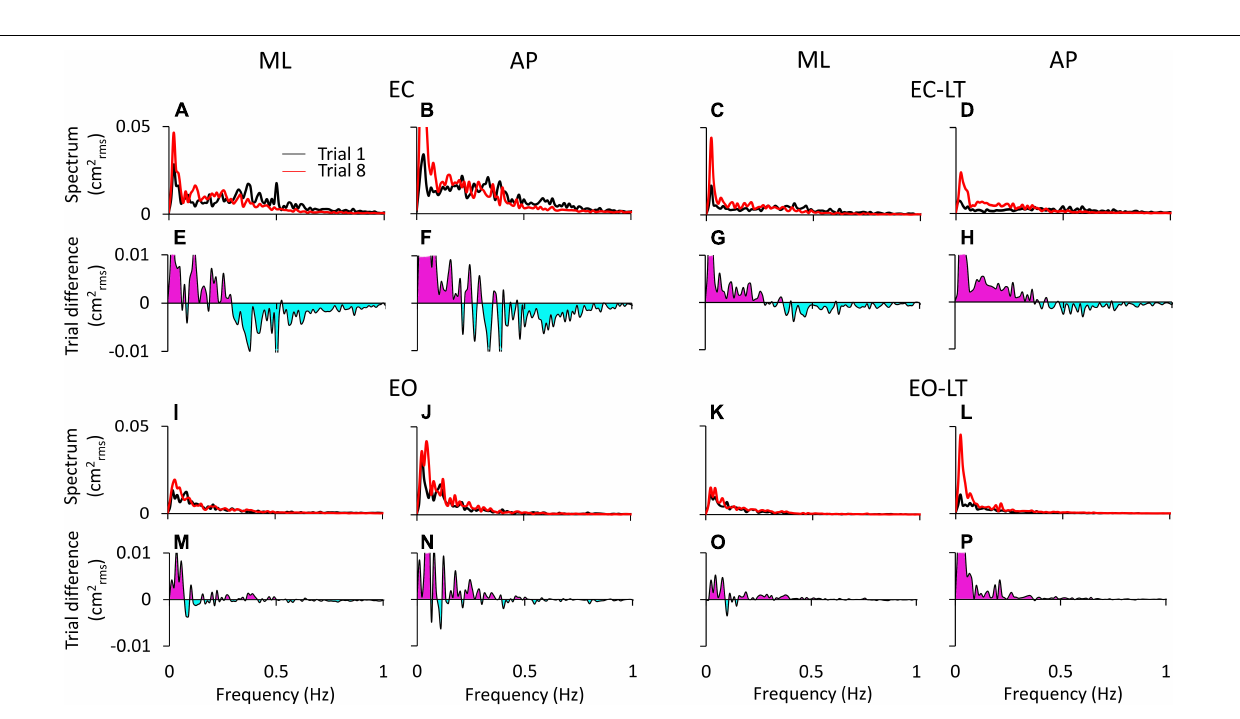
FIGURE 3 | Power spectrum differences between the first and last trials. The profiles of the mean power spectrum of the first (black traces) and last (red traces) trials for both ML and AP directions are superimposed for EC (A,B) , EC-LT (C,D) , EO (I,J) , and EO-LT (K,L) . In the panels from (E–H , M – P) , the differences between the spectrum of the last and the first trial (trial 8 minus trial 1) are reported. The pink area indicates a positive difference, i.e., in the corresponding frequency range, the spectrum of the last trial is greater than that of the first trial. The negative differences are highlighted in light blue, indicating that the spectrum of the last trial is smaller than that of the first